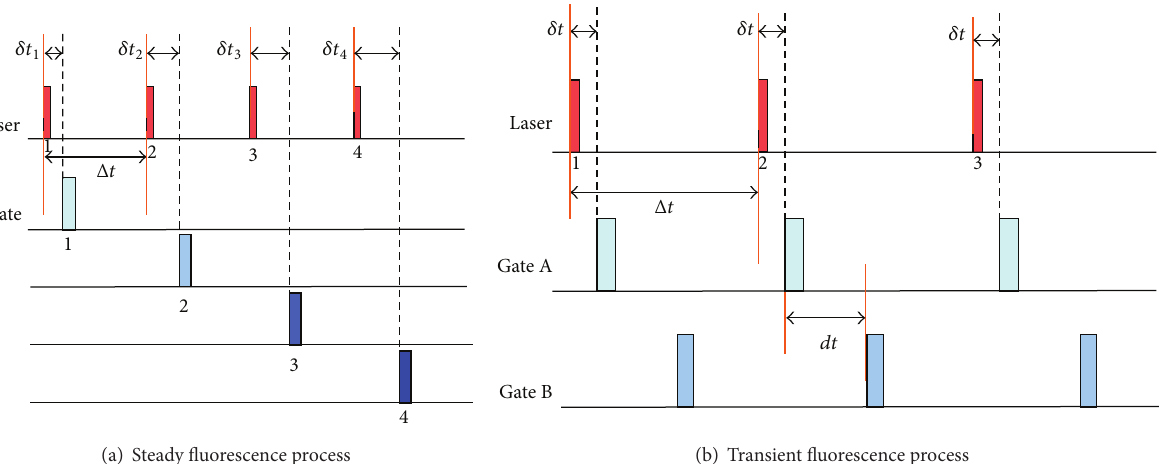
Figure 4: Operating mode and timing design for time-gated FLIM.